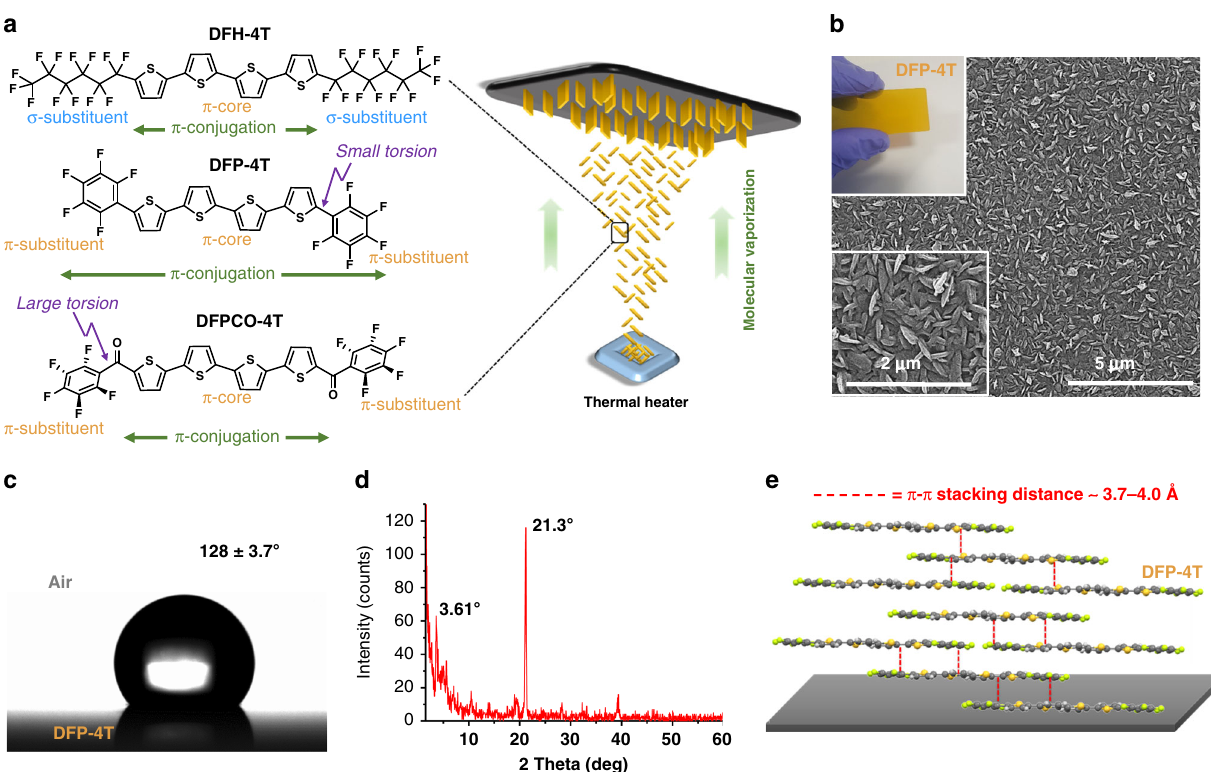
Fig. 1 Fabrication and characterization of nanostructured DFP-4T fi lms. a Chemical structures of the 4T-based semiconductors of this study depicting the extension of π -conjugation as a function of ( σ - vs π -) substituents and torsion angles, and schematic illustration of the PVD process for fabricating the nanostructured SERS fi lms. b SEM images of the DFP - 4T fi lms (top inset shows the optical image of the DFP - 4T fi lm). c Optical image of a water droplet on the DFP - 4T fi lm indicating the water contact-angle. d The θ − 2 θ XRD pattern of the DFP - 4T fi lm. e Schematic illustration of the proposed molecular packing diagram in the out of plane direction showing representative π - π interactions (red dashed